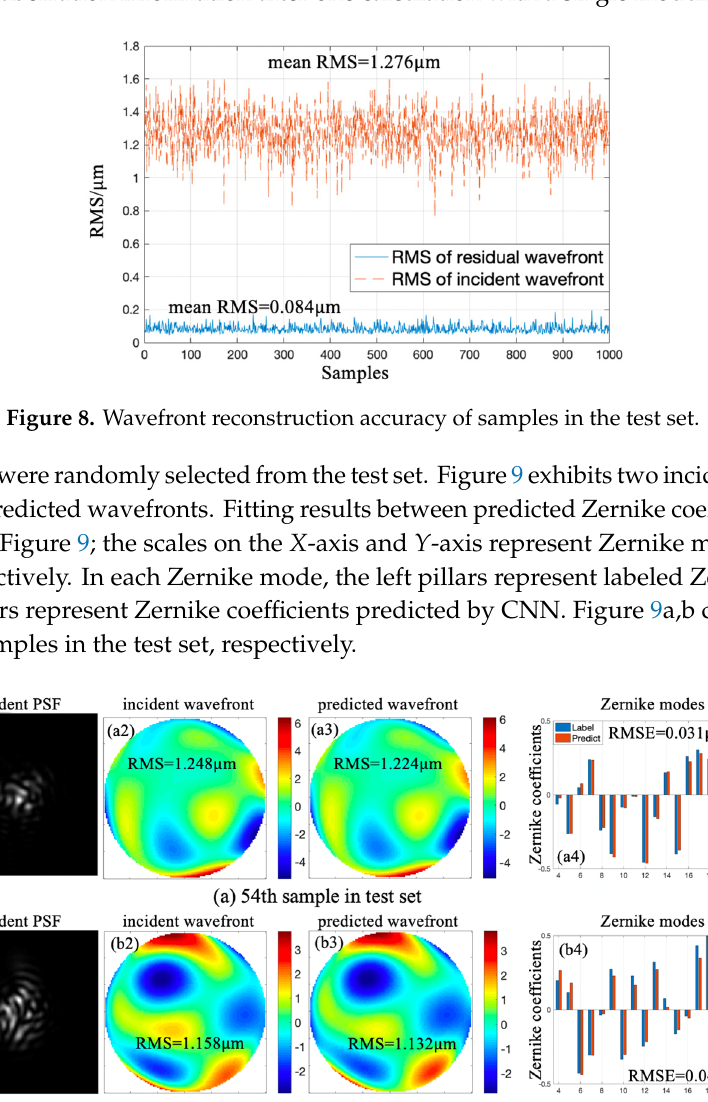
Figure 8. Wavefront reconstruction accuracy of samples in the test set.